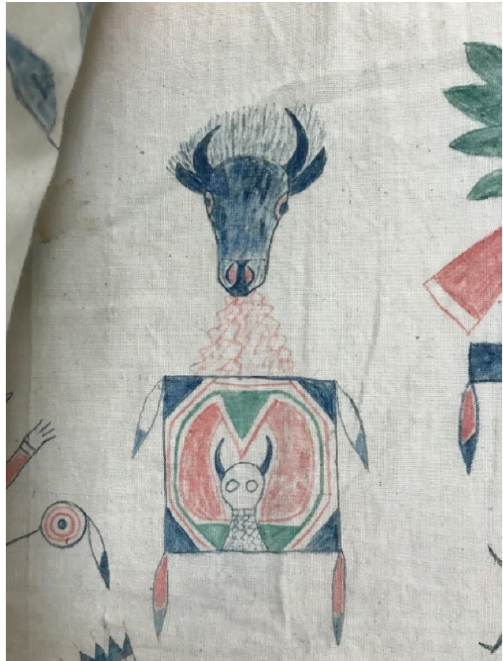
Figure 7. Painting on Mulin (detail) Attributed to Siyosapa (Hunkpapa/Yanktonai) Collected at Fort Peck, Montana in 1880/1881. Cotton muslin, paint, 259 cm × 178 cm. Used by permission of National Museum of Natural History (EL81-0).